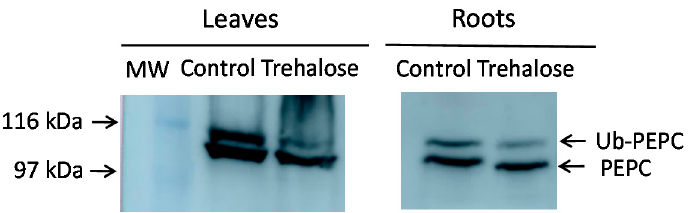
Figure 1. Trehalose decreases the monoubiquitination of Arabidopsis phospho enol pyruvate car- boxylase (PEPC). Arabidopsis plants were hydroponically grown and, when indicated, 1% (29 mM) trehalose was supplied to the culture medium for 48 h. The leaves and roots from six-week- old plants were pooled (30 plants). Protein aliquots corresponding to 10 mU of PEPC were ana- lyzed by SDS-PAGE and immunoblotted with anti-PEPC antibodies. The arrows show monoubiq- uitinated (Ub-PEPC) and non-monoubiquitinated PEPC. MW, molecular mass markers. The two images are of the same membrane, although several lanes are omitted for clarity.